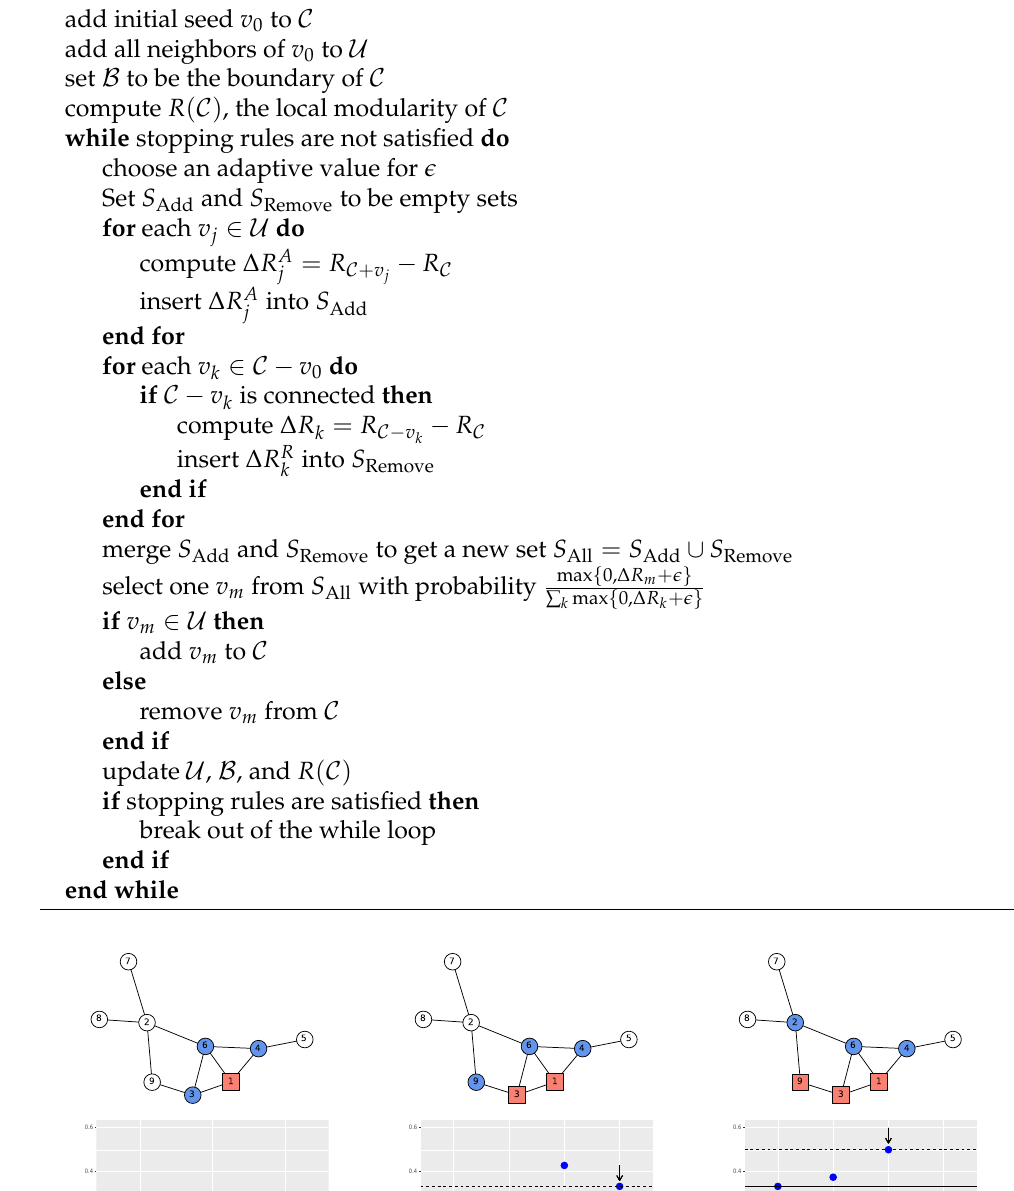
Algorithm 1 The algorithm for the stochastic maximization of local modularity.